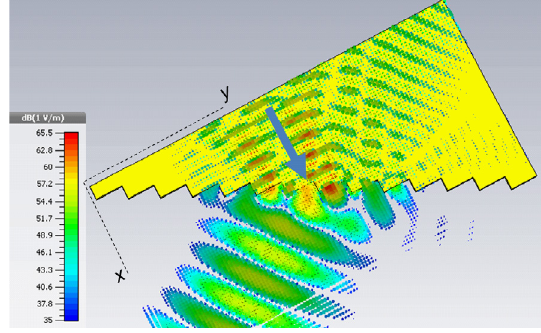
Fig. 2. CST E - fi eld results for Gaussian beam incidence from the prism into the air. See Supplementary Material for an animated version of this